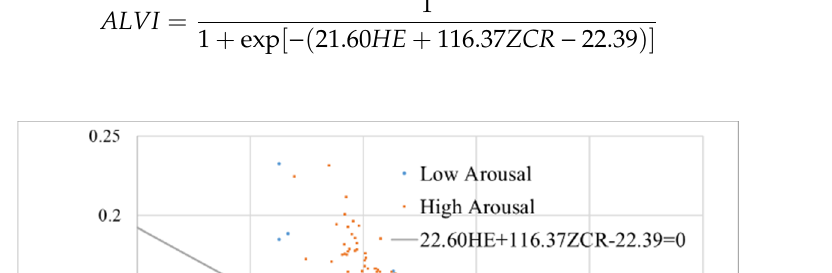
Figure 2. Receiver operating characteristic curve when arousal level voice index identifies utterance data of low arousal level and high arousal level in the Interactive Emotional Dyadic Motion Capture